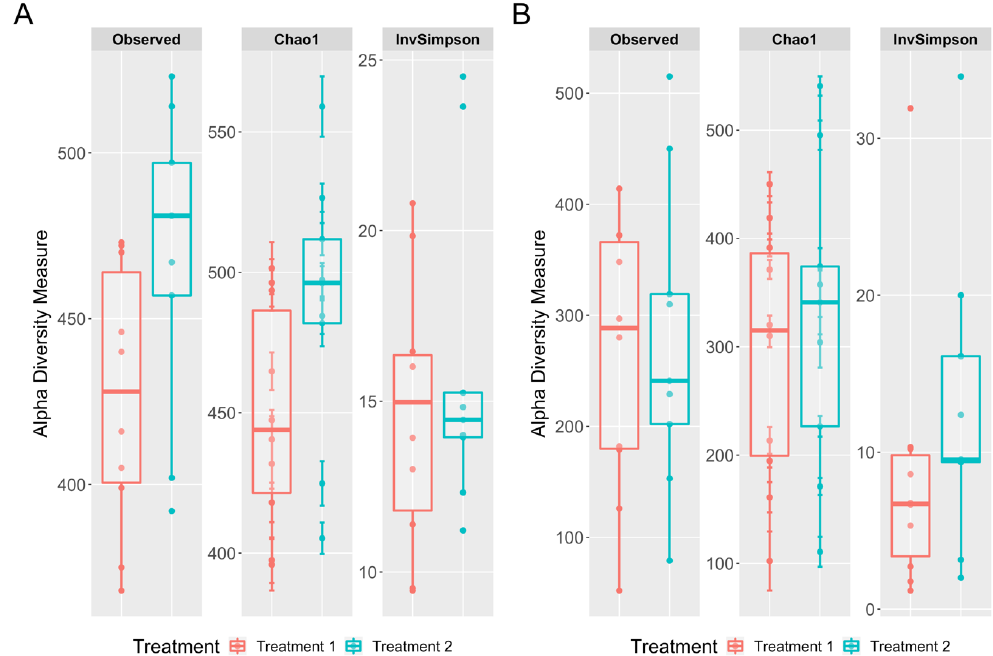
Figure 5. ( A ) Boxplot of the observed, Chao1, and Inverse Simpson (InvSimpson) measurements for the alpha diversity of the cecal content samples by treatment. ( B ) Boxplot of the observed, Chao1, and Inverse Simpson (InvSimpson) measurements for the alpha diversity of the cloacal swab samples by treatment.